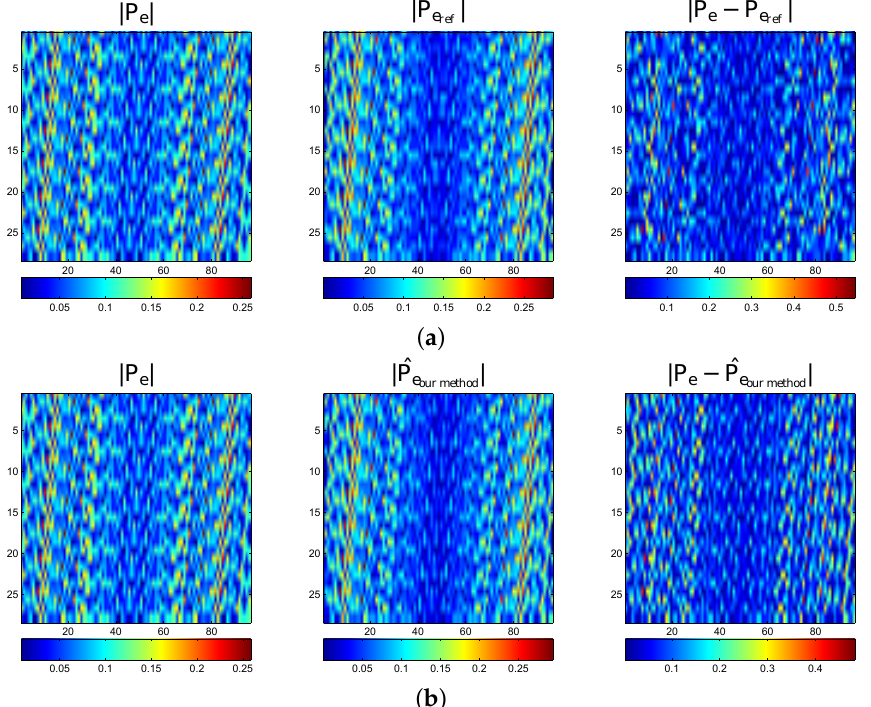
Figure 12. Comparison between theoretical matrix and calibration matrices estimated from real measurements ( left : Modulus of theoretical sensing matrix; middle : Modulus of estimated sensing matrix; right : Modulus of difference). ( a ) Reference calibration. ( b ) Our proposed